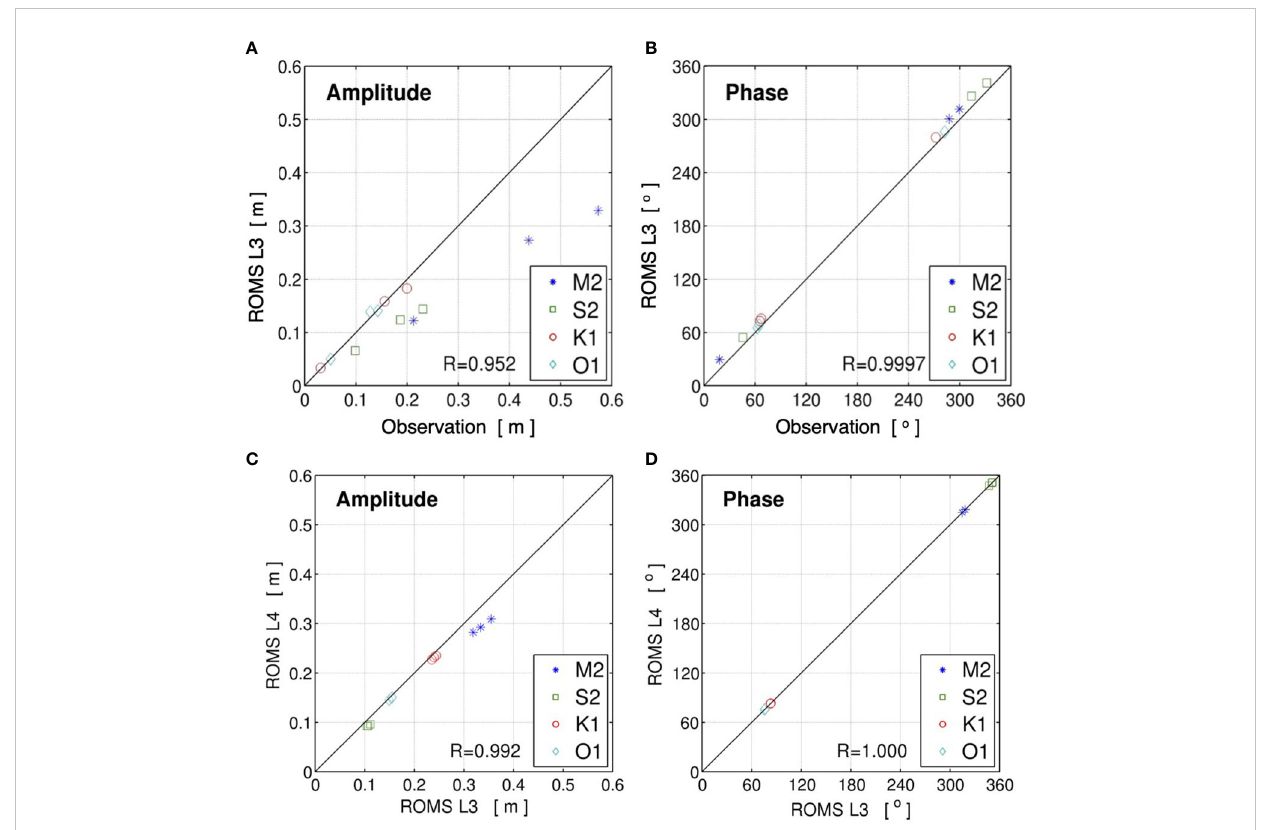
FIGURE 2 Scatter diagrams of the four major principal tidal constituents (M2, S2, K1, and O1) derived from harmonic analysis of the surface elevations. Upper panels show (A) the amplitude and (B) phase epoch from the ROMS-L3 and in situ observation at three tide gauge stations around the Okinawa Island shown by blue circles in Figure 1. Lower panels show (C) the amplitude and (D) phase epoch from the ROMS-L3 and ROMS-L4 models at the three virtual tide gauge stations shown by pink squares in Figure 1. R in each plot indicates the correlation coef fi